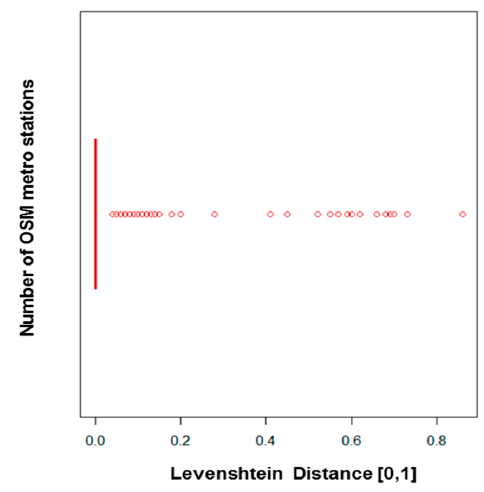
Figure 14. Comparison of names of homologous subway stations using the Levenshtein distance.